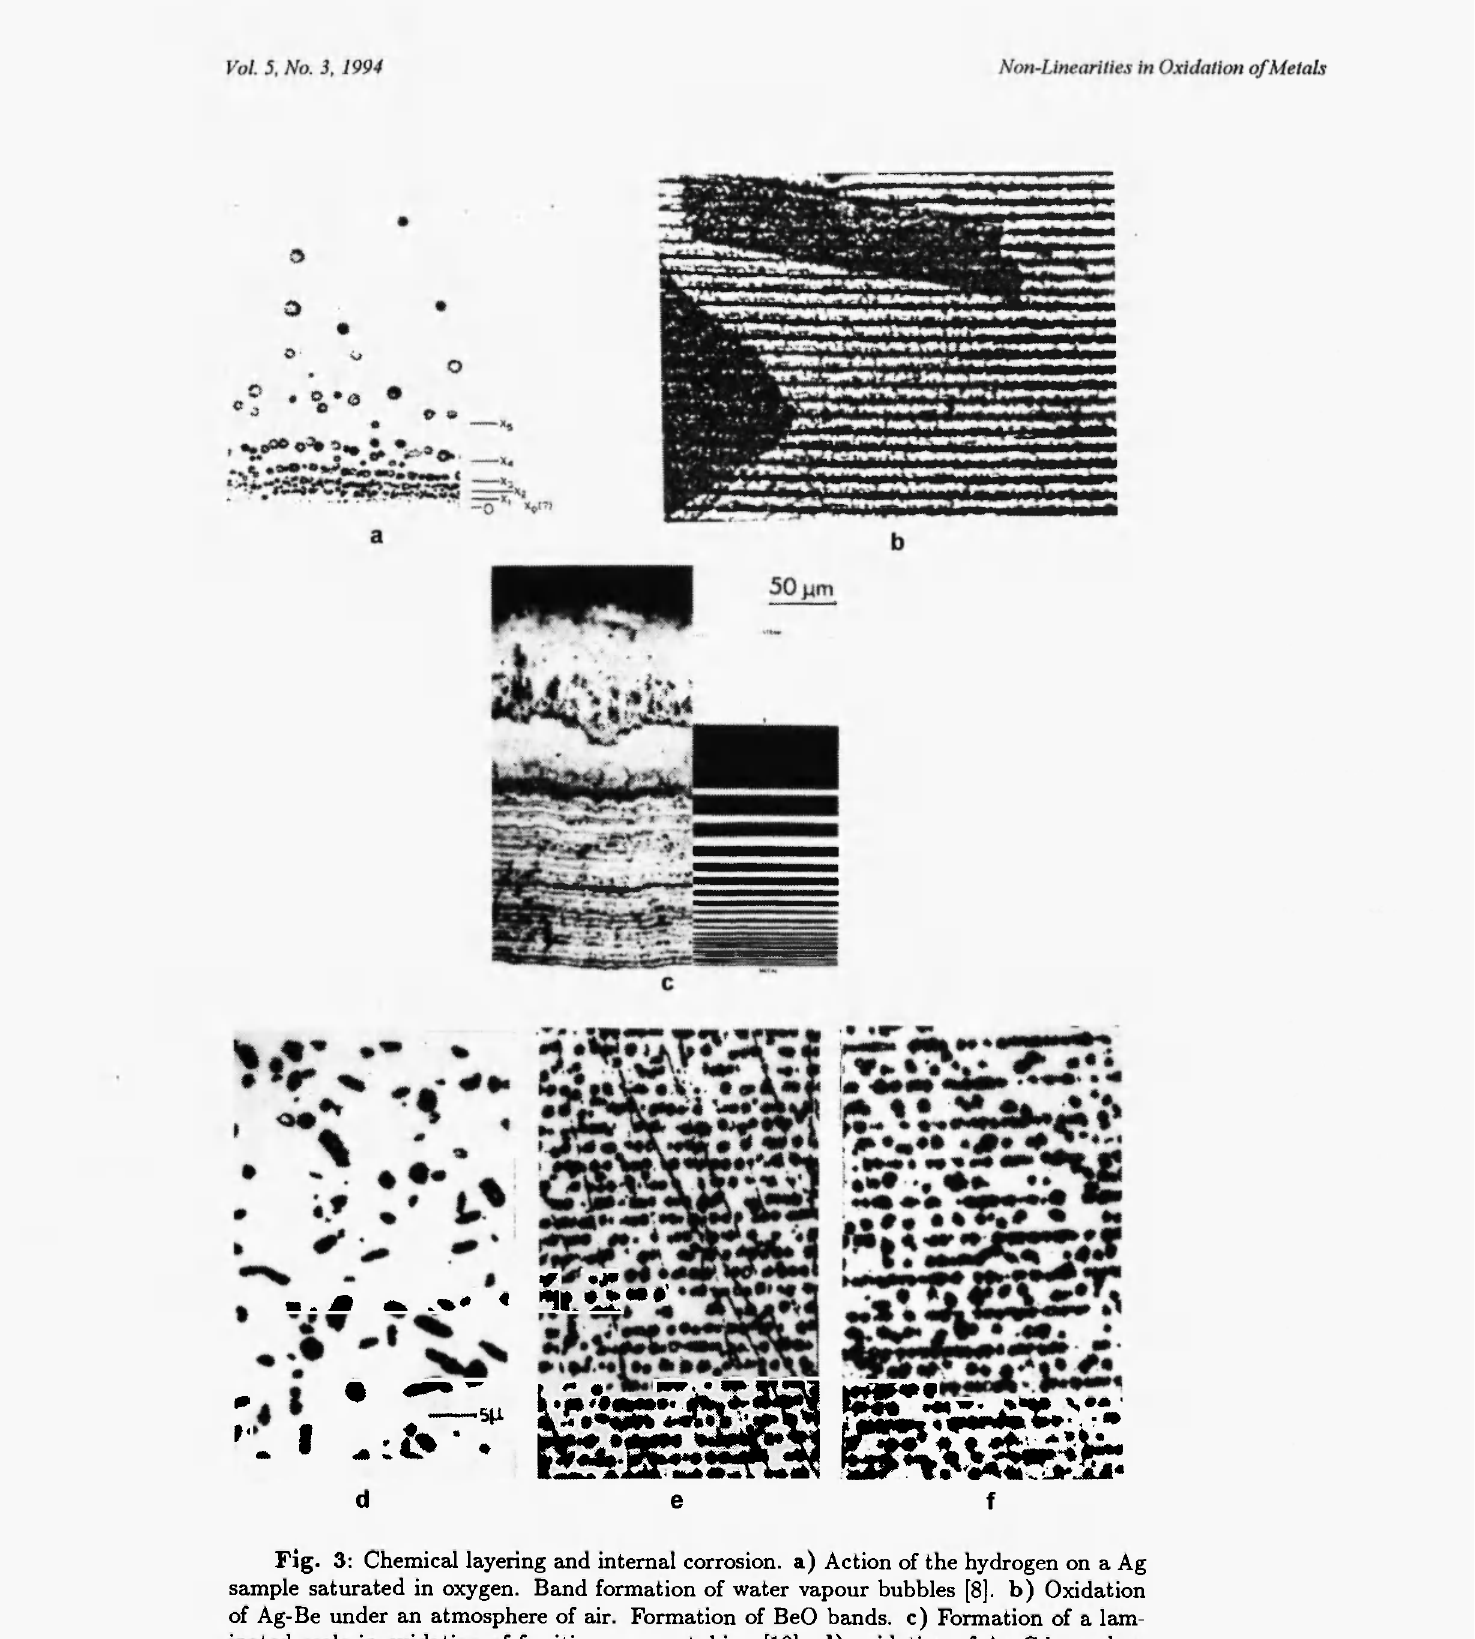
Fig. 3: Chemical layering and internal corrosion, a) Action of the hydrogen on a Ag sample saturated in oxygen. Band formation of water vapour bubbles [8]. b) Oxidation of Ag-Be under an atmosphere of air. Formation of BeO bands, c) Formation of a lam- inated scale in oxidation of ferritic pressure tubing [10]. d) oxidation of Ag-Cd, random precipitation of CdO [11], e-f) Oxidation of Ag-Cd-Mg. Periodic precipitation of